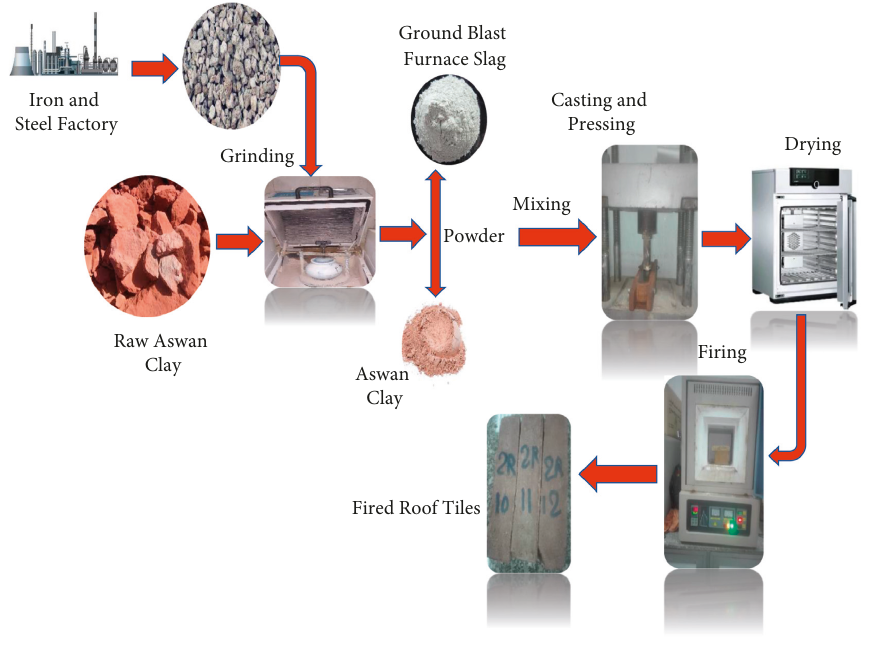
Figure 1: Experimental